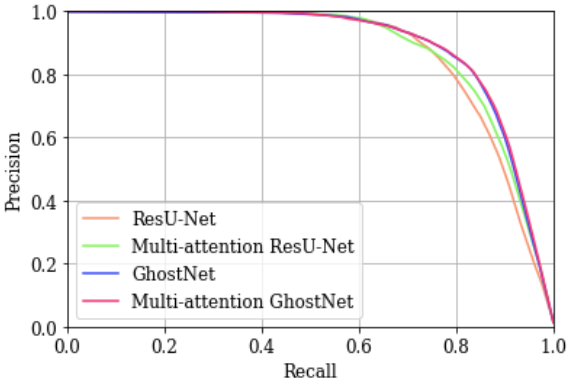
Figure 4. Recall vs. Precision curves of the deep learning architectures.